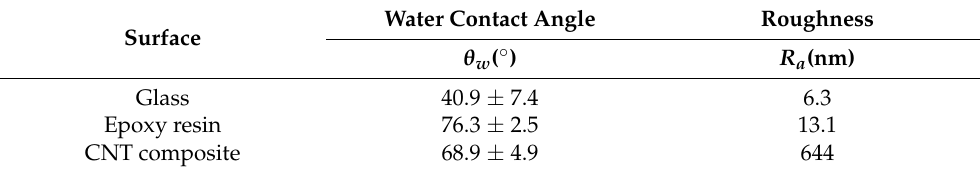
Table 2. Water contact angle measurements ( θ w ) and roughness ( R a ) determined for the tested